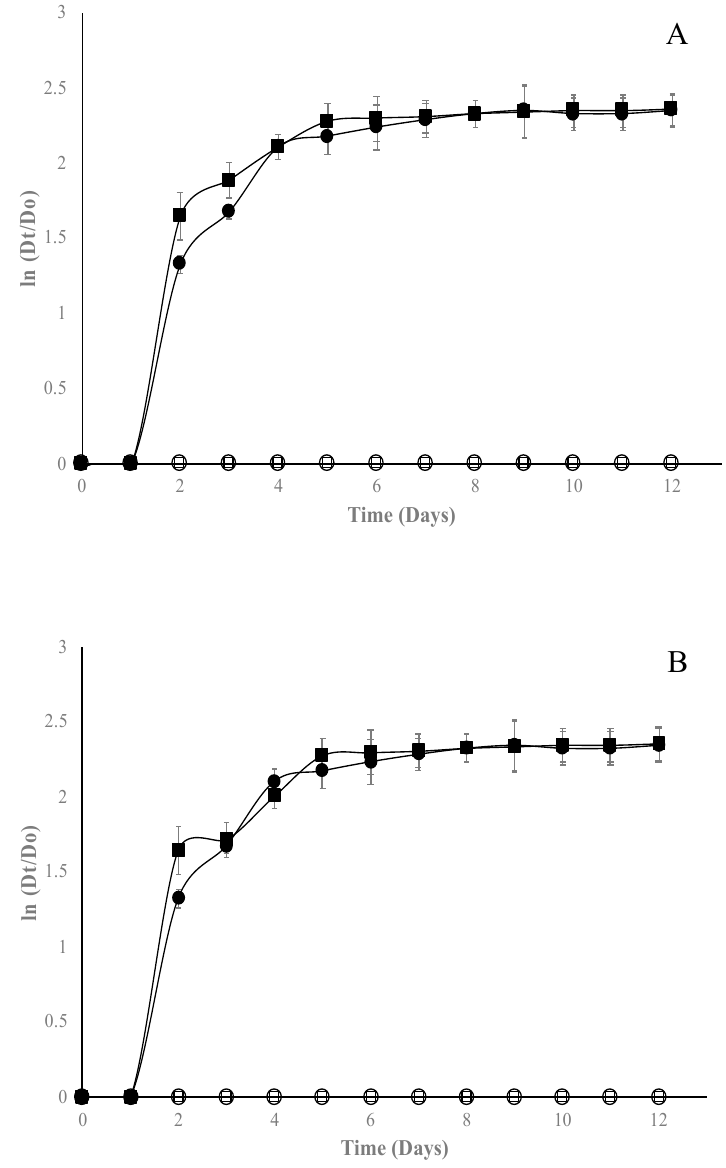
Figure 4. Effect of starch edible films added with selected concentrations of Mexican oregano ( Lippia berlandieri Schauer) essential oil (control [ (cid:4) ], 0% [ (cid:8) ], 1% [ (cid:3) ], and 2% [ ]) on Aspergillus niger growth with different nanocomposites, bentonite ( A ) or halloysite ( B ).